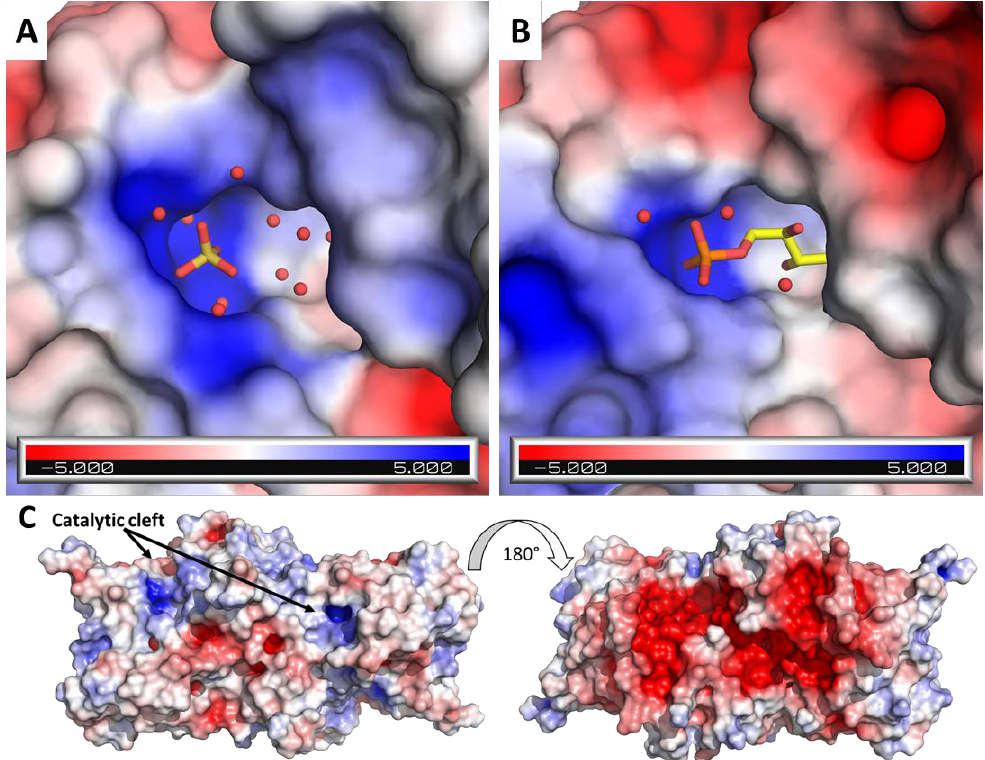
Figure 5. Electrostatic potential of RPI surface. ( A ) View of the catalytic cleft of CrRPI1 electrostatic surface calculated by PyMOL APBS and represented in a gradient from blue (electropositive) to red (electronegative). The sulfate ion is represented in sticks and water molecules as spheres. ( B ) View of the catalytic cleft of Legionella pneumophila RpiA of PDB model 6MC0, superposed to CrRPI1 model and colored as in A. Co-crystallized ribose-5-phosphate is represented in sticks. ( C ) Electronegative patch of CrRPI1 dimer. Electrostatic surface of CrRPI1 dimer facing the catalytic cleft up and with a 180° rotation from this position was calculated by PyMOL APBS.